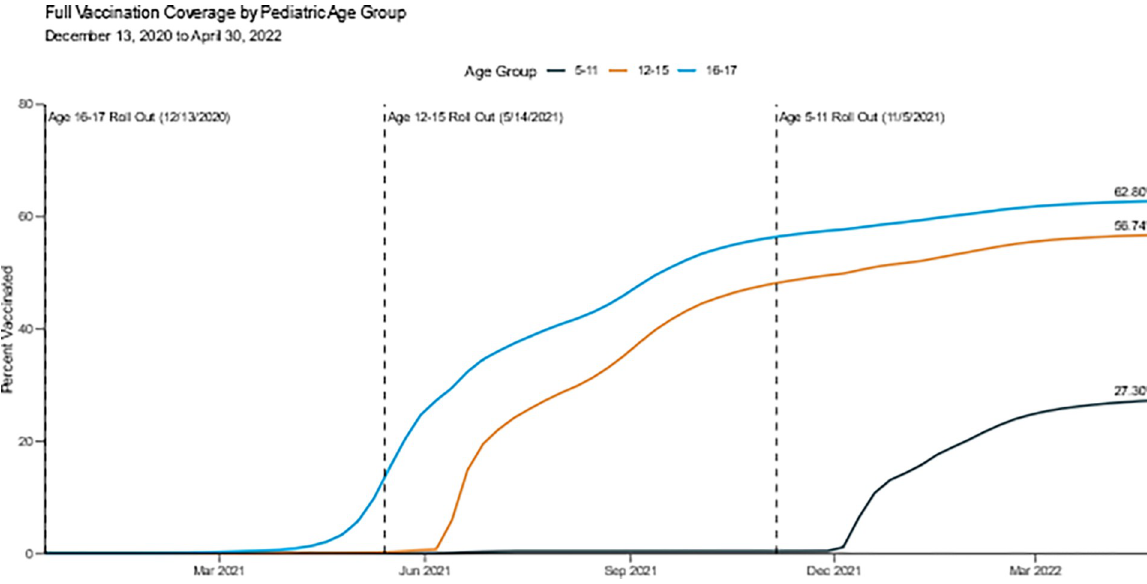
Fig 1. Weekly “fully vaccinated” pediatric vaccination coverage rates by age group among children aged 5–17 years, U.S., from December 13, 2020, through April 30,